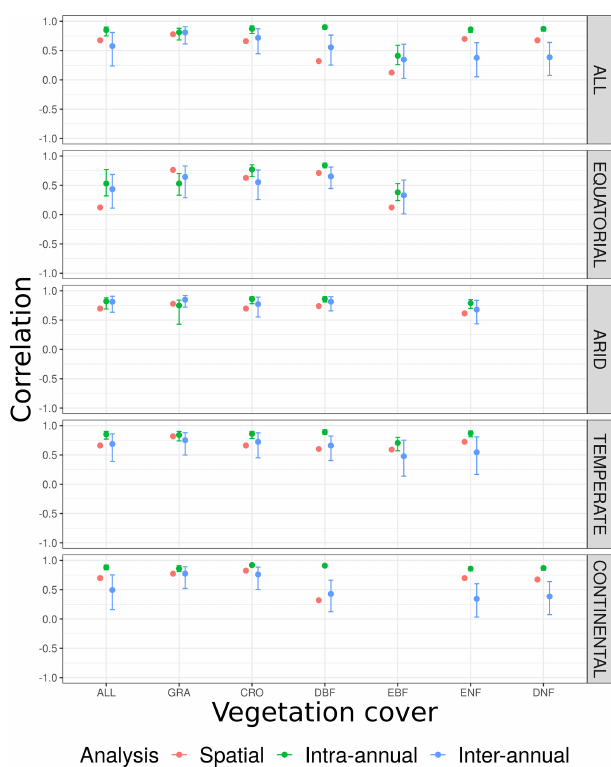
Figure 4. Pearson’s correlation coefficient, r , between downscaled SIF and FLUXCOM GPP for the spatial relationship, intra-annual temporal relationship within a growing season and the inter-annual temporal trend across years. For the spatial analysis, a single global spatial correlation is calculated for each vegetation cover and cli- mate zone, whilst the temporal relationships display the median global correlation and 25% upper and lower quantiles for each pixel, broken down by vegetation cover and climate